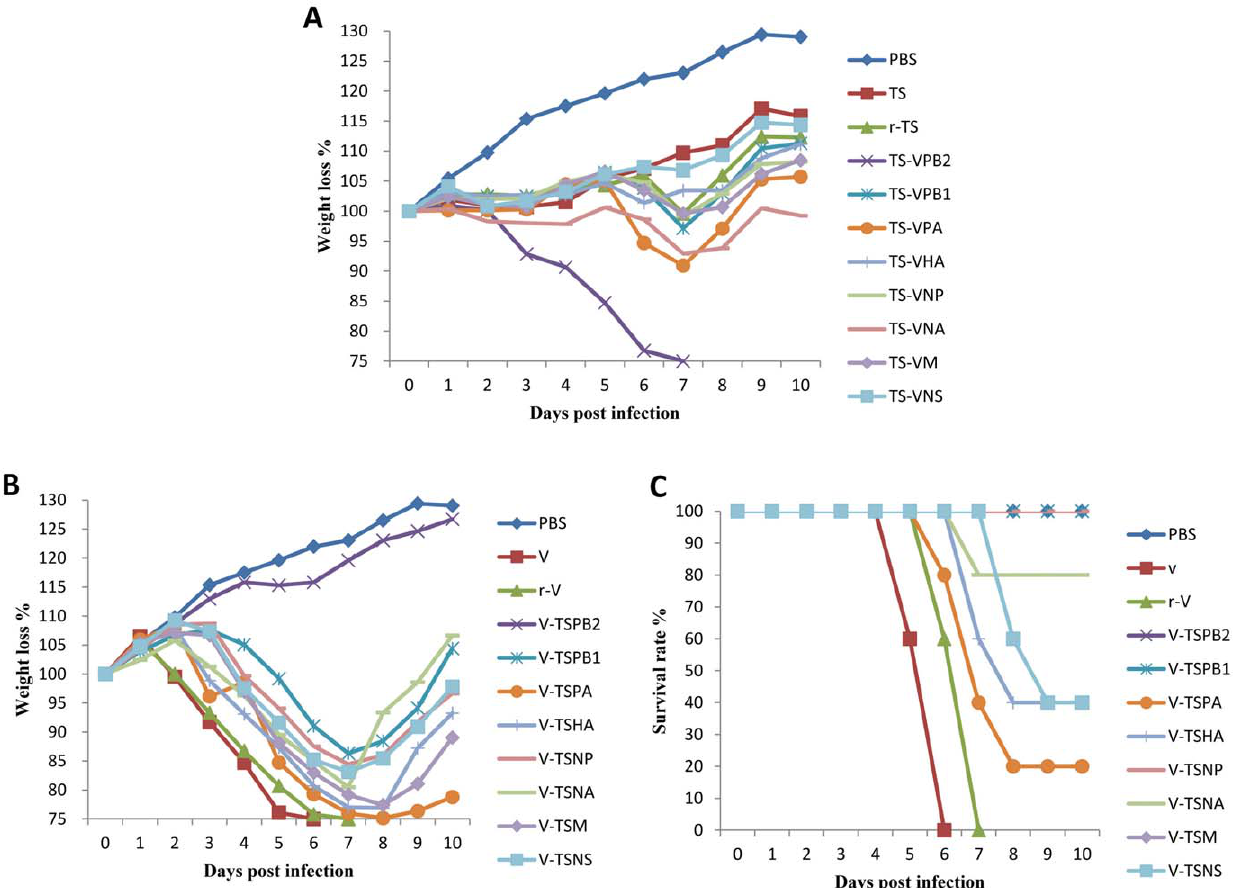
Figure 2. Weight changes of mice infected with wild-type, parental and recombinants viruses. A) Weight changes of mice inoculated with the wild-type TS, parental r-TS and recombinant viruses. B) Weight changes of mice inoculated with the wild-type V, parental r-V and recombinant viruses.